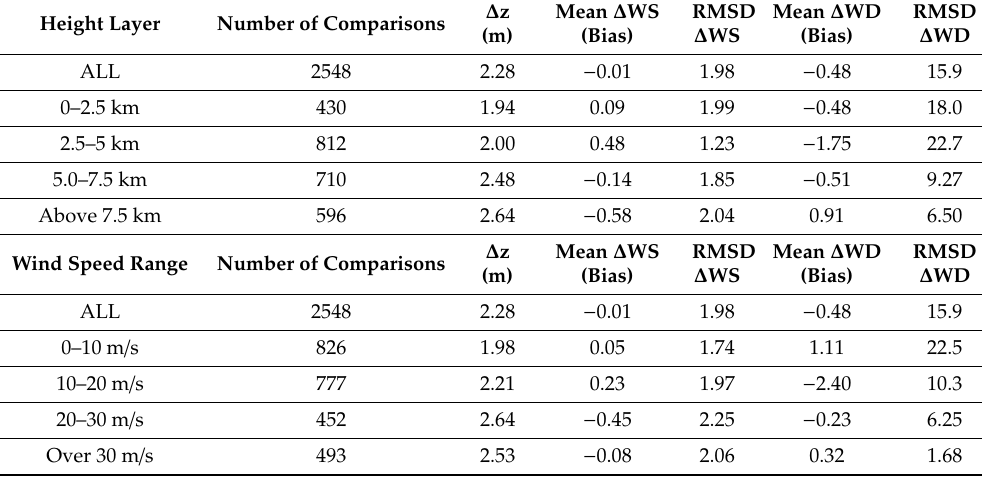
Table 6. Quantitative comparisons of DAWN and dropsonde wind speed and wind direction during PW2 as subsetted by height (top) and DAWN wind speed